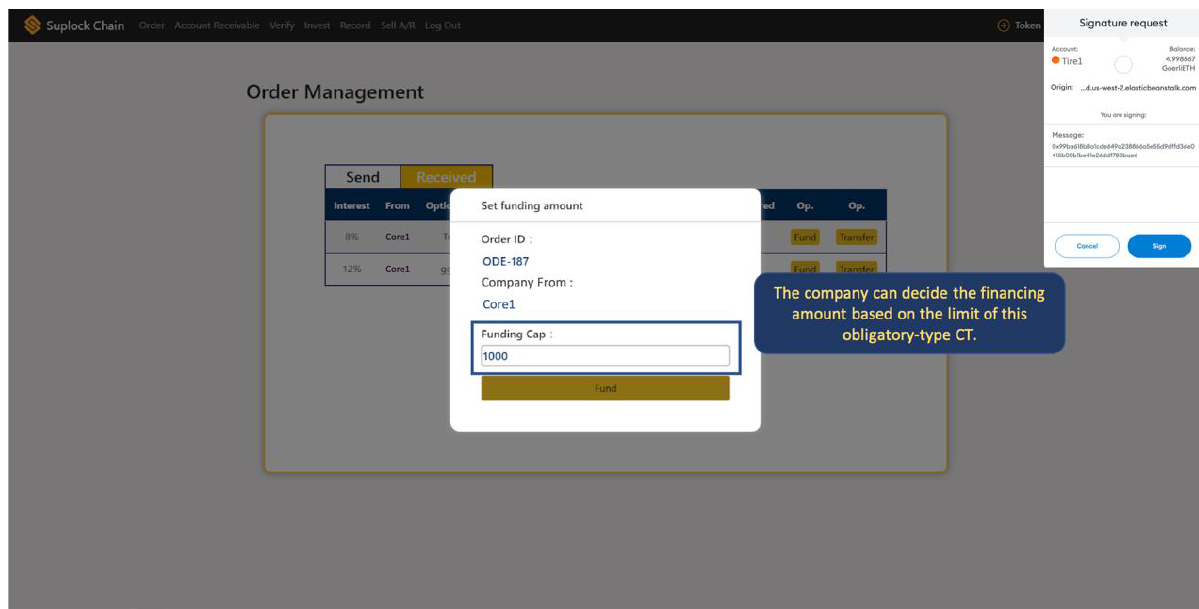
Figure A10. Module for issuing funding request. Tire 1 request funding by collateral order from Core 1 on our website.